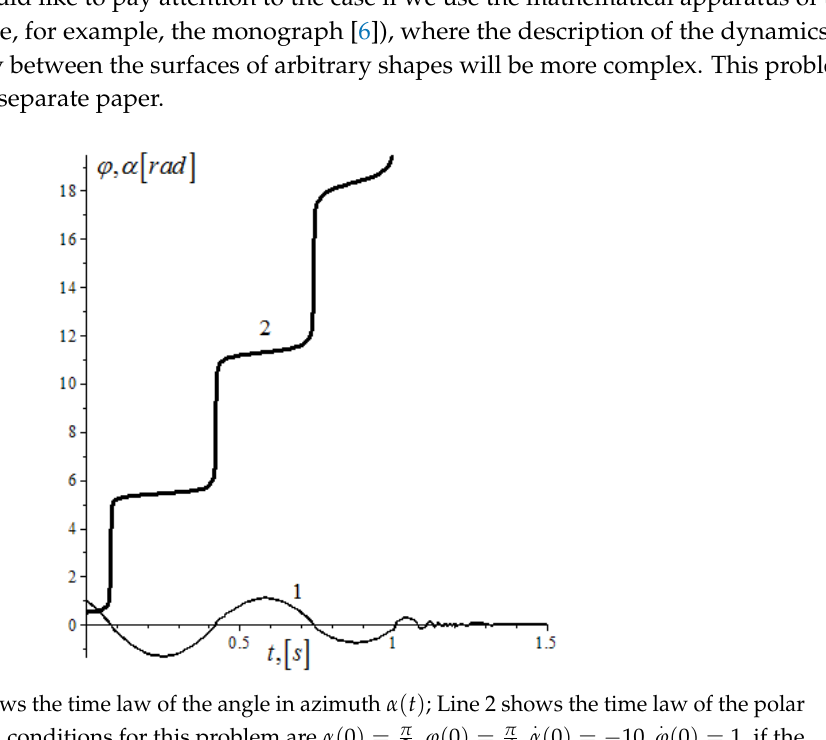
. . α ( 0 ) = − 10, ϕ ( 0 ) = 1, if the , ϕ ( 0 ) = π , 3 6